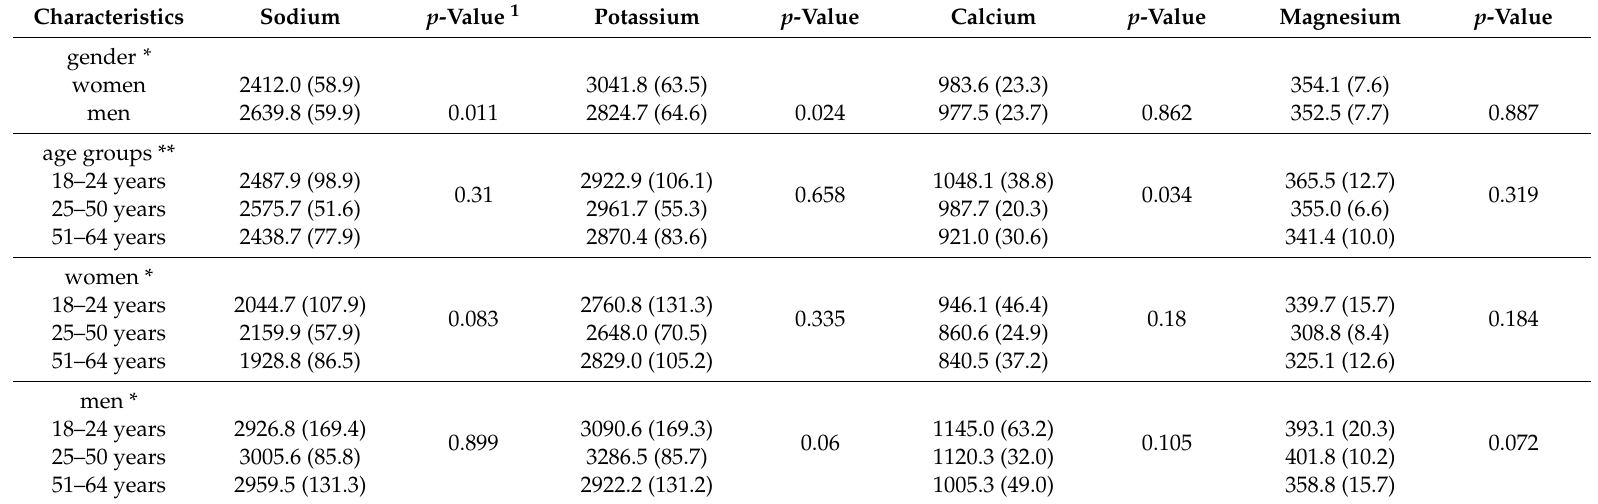
Table 3. Electrolyte intake in association with gender and age groups. Data shown as adjusted mean values and standard error of the mean (SE) in parentheses in mg /